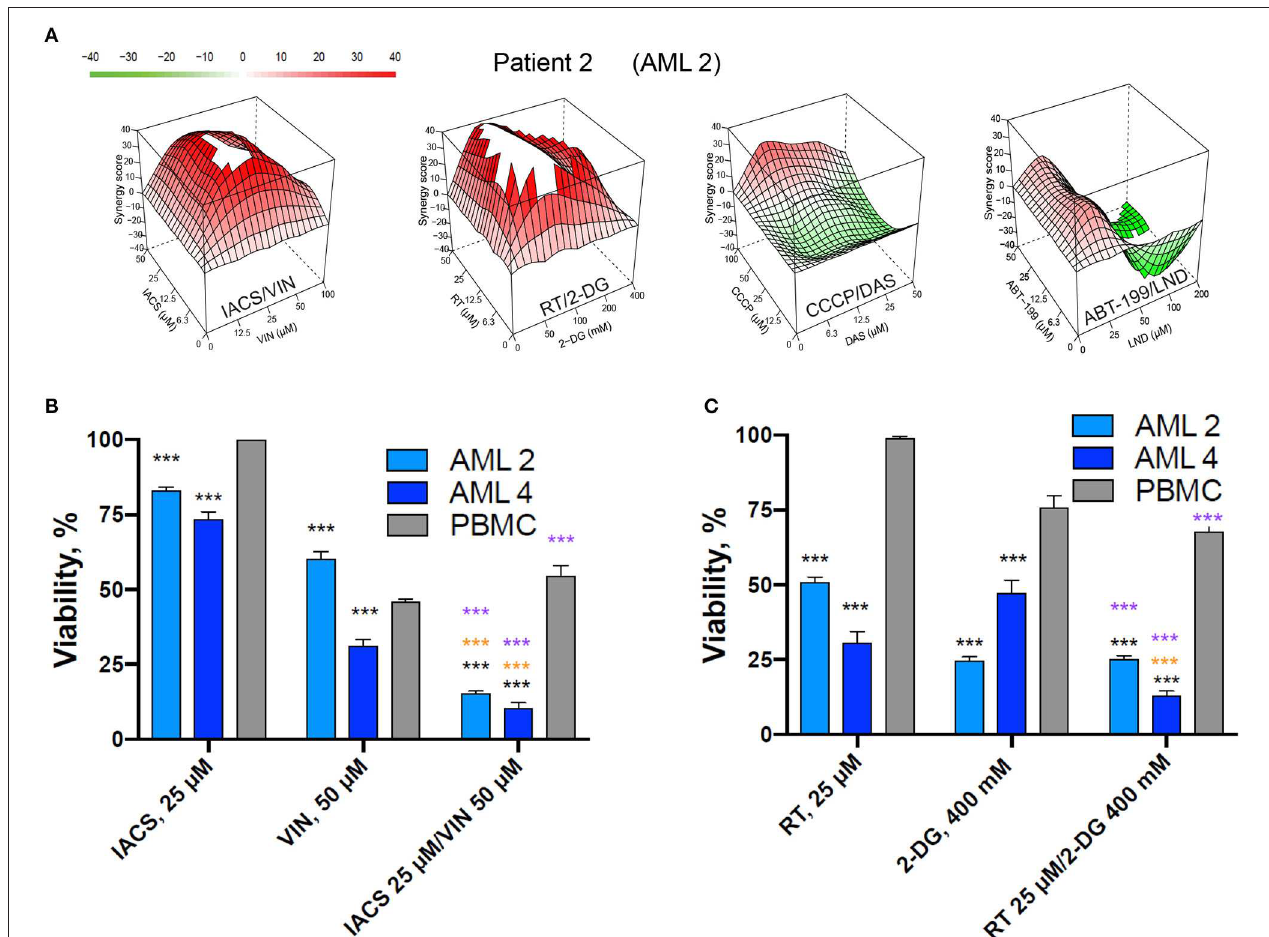
FIGURE 10 | Selected mitocan-based drug combinations retain their synergy in primary AML samples. (A) Synergy landscapes for representative patient sample treated with IACS-010759/vinorelbine, rotenone/2-deoxy-D-glucose, CCCP/dasatinib, or ABT-199/lonidamine. Drug combination landscapes: z-axis , synergy score (ranges from − 40, green, to + 40, red); x/y-axes , drug1/drug2 concentration range, respectively. For drug1/drug2 concentration ranges refer to Table S5 . Drug combination landscapes were built using Bioconductor package “synergyfinder.” One representative replicate (with maximal synergy closest to the average value of three biological replicates) is shown. (B,C) The effect of two selected drug combinations (IACS-010759/vinorelbine or rotenone/2-deoxy-D-glucose) with highest average synergy and corresponding single drugs on primary AML samples or healthy PBMCs. Shown are mean ± SEM from three independent biological replicates. Significance of changes in survival was assessed via Student’s t -test. *** p < 0.001. Black stars indicate comparison of primary AML cells vs. healthy PBMCs under the same treatment condition; purple stars indicate significantly lower survival under combinatorial treatment compared to single mitocan for each cell type; orange stars indicate significantly lower survival under combinatorial treatment compared to single complementary drug for each cell